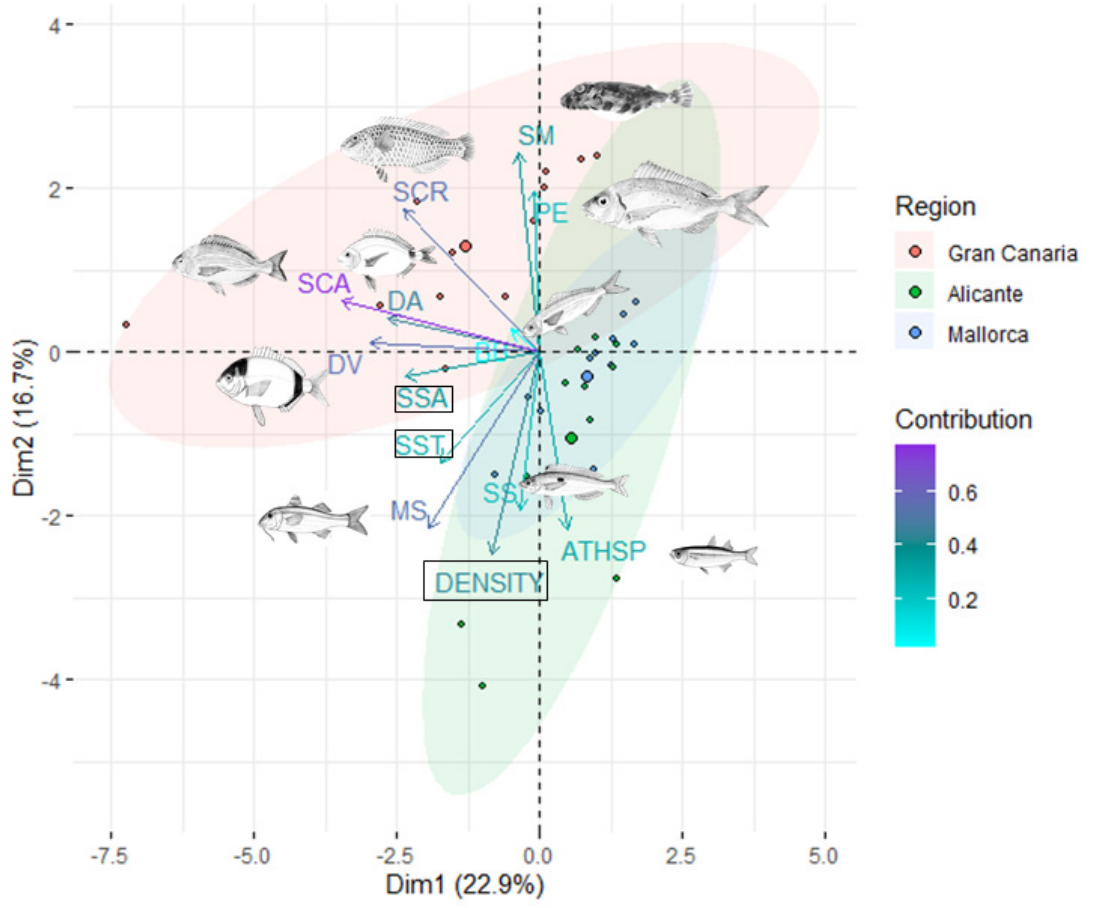
Figure 6. Redundancy analysis (RDA) examining variation in fish assemblage structure according to ocean climate (SST; mean seasonal sea surface temperature) and seagrass structure descriptors (SSA: seagrass surface area, and DENSITY: seagrass shoot density). The 10 most abundant fish species are included; BB: Boops boops, ATHSP: Atherina sp., DA: Diplodus annularis, SS: Spicara smaris , SCA: Spondyliosoma cantharus , SCR: Sparisoma cretense , DV: Diplodus vulgaris , SM: Sphoeroides marmoratus , PE: Pagellus erythrinus and MS: Mullus surmuletus . The colors of the arrows indicate their contribution relative to the variance explained by the axis, and the colors of the different circles represent meadows from each region. Centroids for each region are depicted by large-size dots. Ellipsoids show confidence limits (0.95) in areas encompassing fish assemblages from each region. All fish images were downloaded from the FAO.org webpage, except Sphoeroides marmoratus , whose authorship belongs to Pedro M. Duarte .